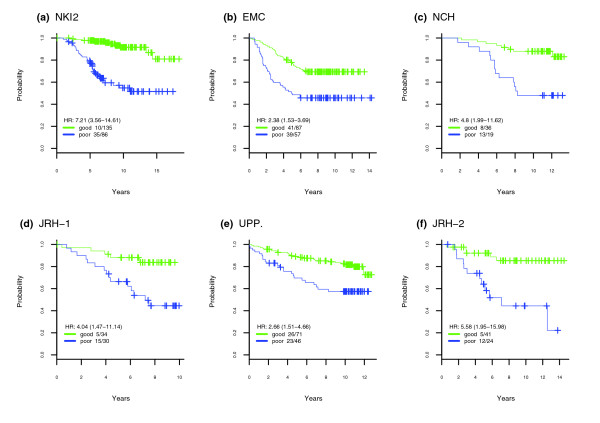
Kaplan-Meier survival curves in cohorts. Kaplan-Meier survival curves for the two prognostic groups derived from pam-clustering (k = 2) [28] on the molecular prognostic index distribution in the three training cohorts (a) NKI2, (b) EMC and (c) NCH, and three external cohorts (d) JRH-1, (e) UPP and (f) JRH-2. We also give the hazard ratio (HR), the associated 95%CI and the number of events (death or distant metastasis) and number of distinct data points in each prognostic group.